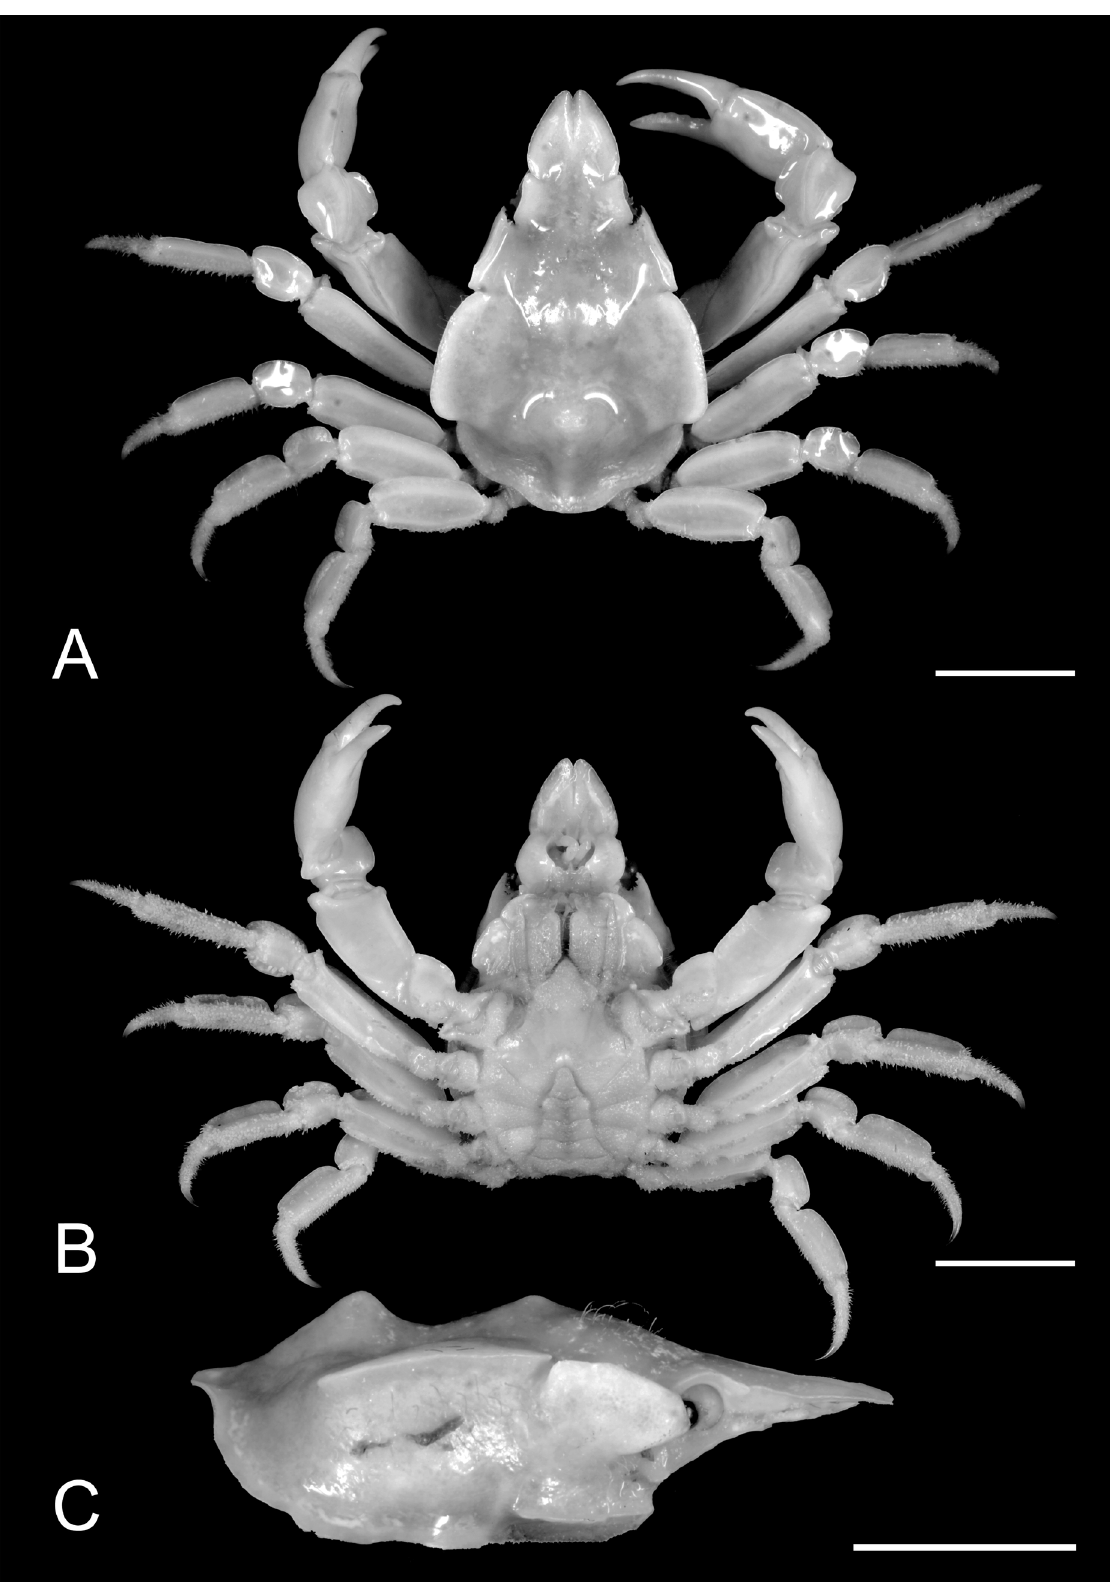
Fig. 14. Stegopleurodon pteridion sp. nov., holotype, ♂ (13.1 × 7.9 mm) (NTOU), South China Sea. A . Overall dorsal view. B . Overall ventral view. C . Lateral view of carapace. Scale bars = 5